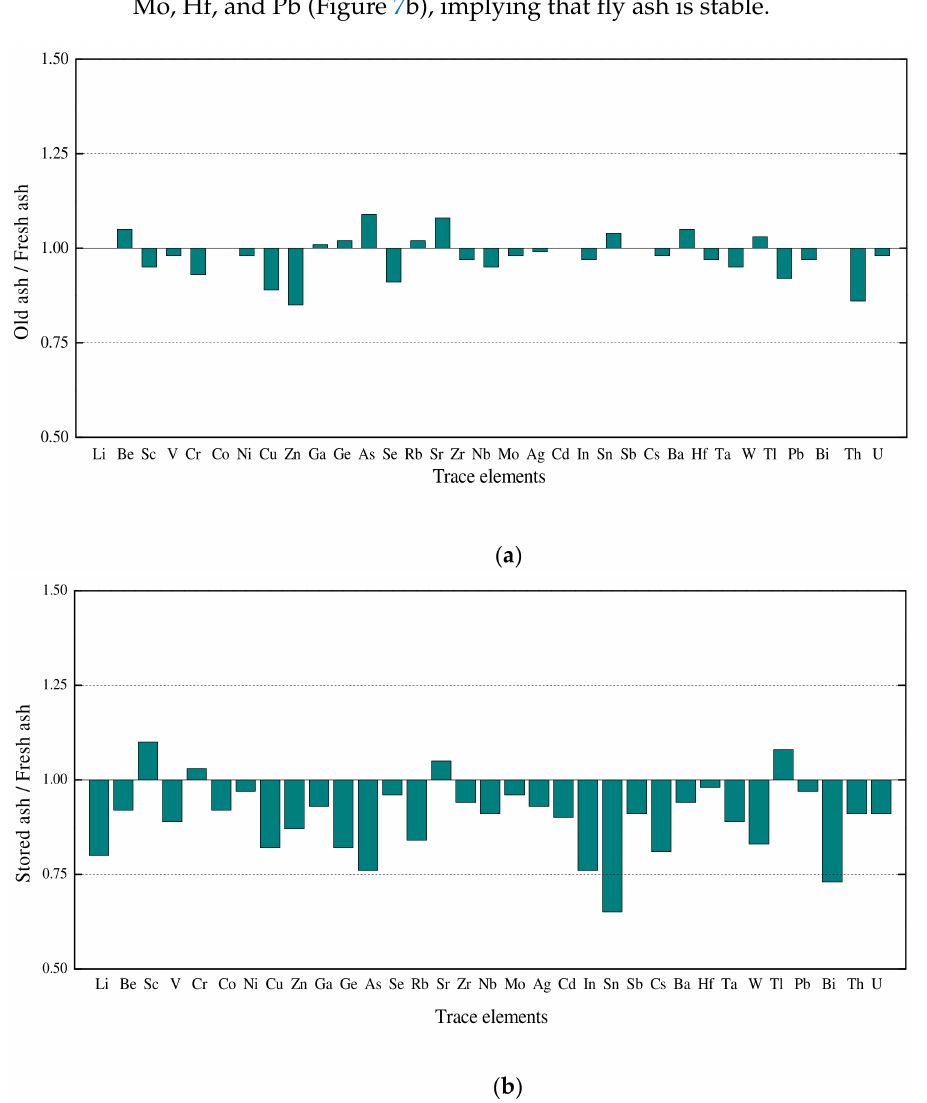
Figure 7. Comparison of trace element concentrations in old and fresh ash ( a ), and in stored and fresh ash ( b ) from the TY power